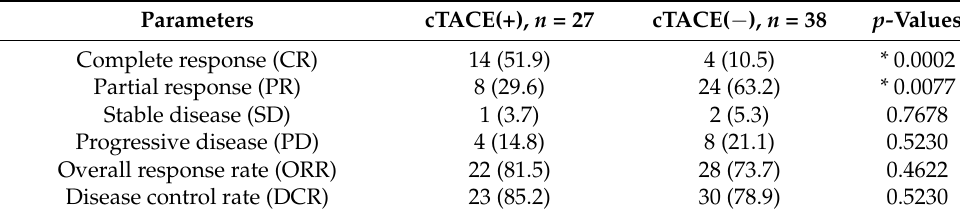
Table 3. Treatment response to additional